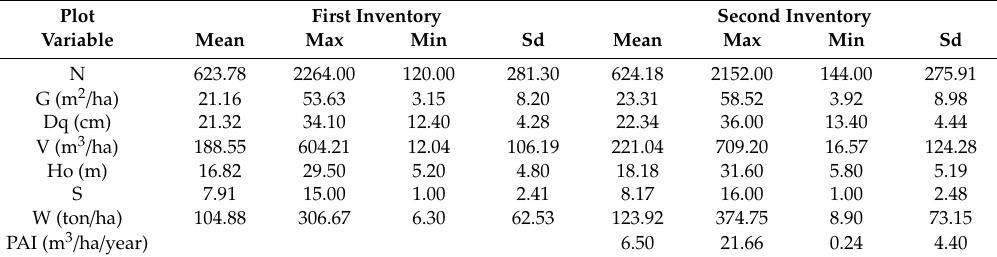
Table 1. Summary statistics of the 217 plots used in this